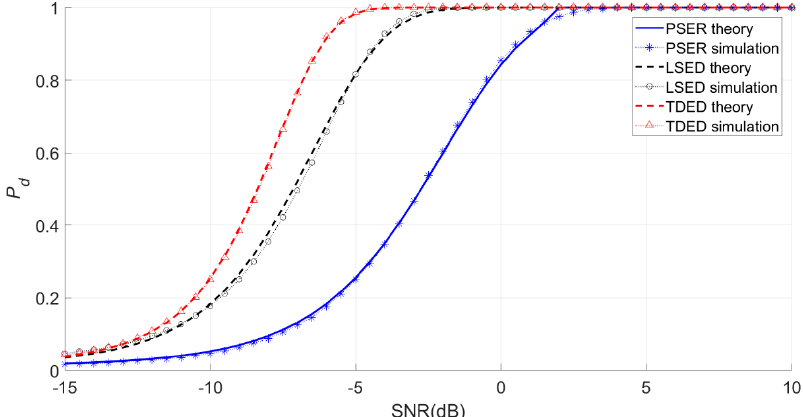
Figure 17. Actual and theoretical detection probabilities obtained by three methods for the Ricker wavelet with local bandwidths of 21–40 Hz. wavelet with local bandwidths of 21–40 Hz.